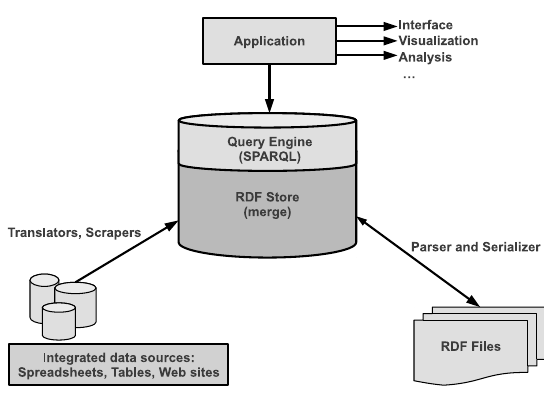
Figure 4: Architecture for accessing the integrated databasis (modified from Allemang and Hendler (2011)).